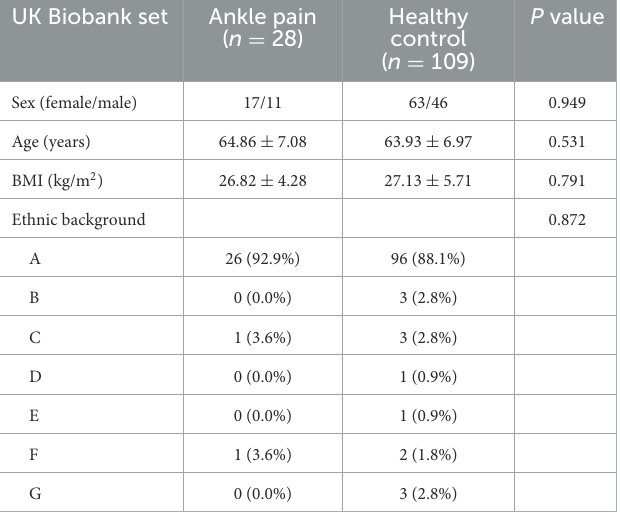
TABLE 1 Demographic variables of ankle pain group and healthy control group presented as mean (SD). UK Biobank set